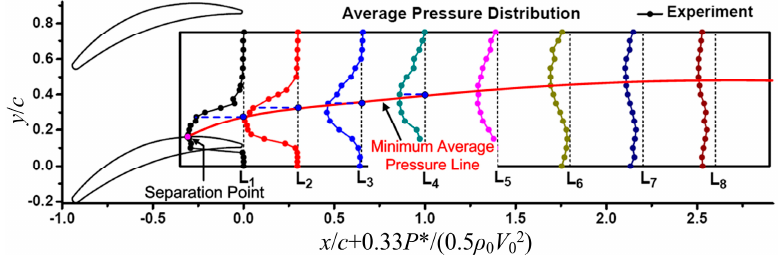
Figure 22. Total pressure of the sensors in the cascade.